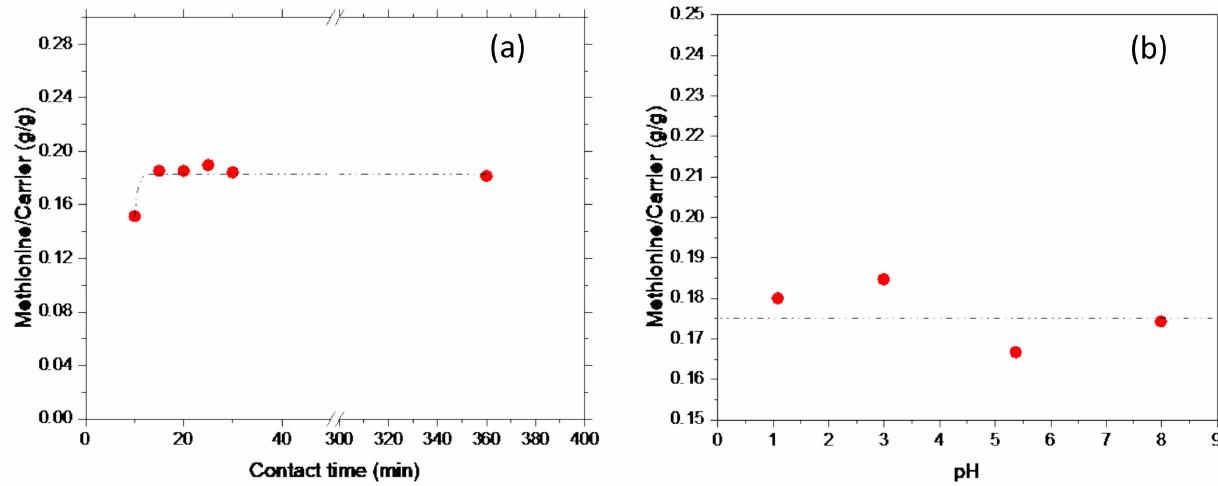
Figure 2. Methionine capture by Adsorbene ® ( a ) at different contact time and ( b ) at different methionine solution